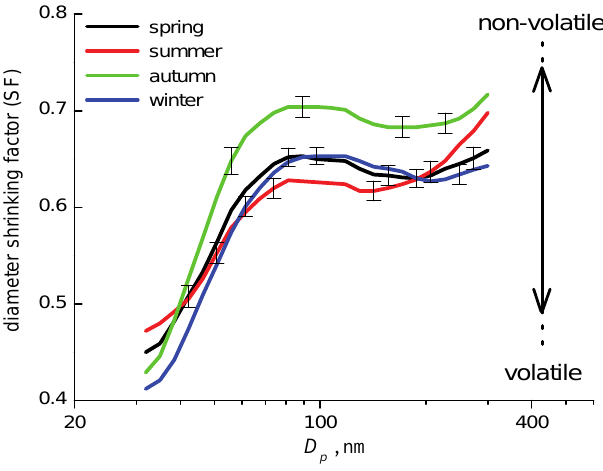
Fig. 9. Average diurnal cycle of the diameter shrinking factor (SF) of 30nm and 80nm particles. The data are also distinguished be- tween weekdays and